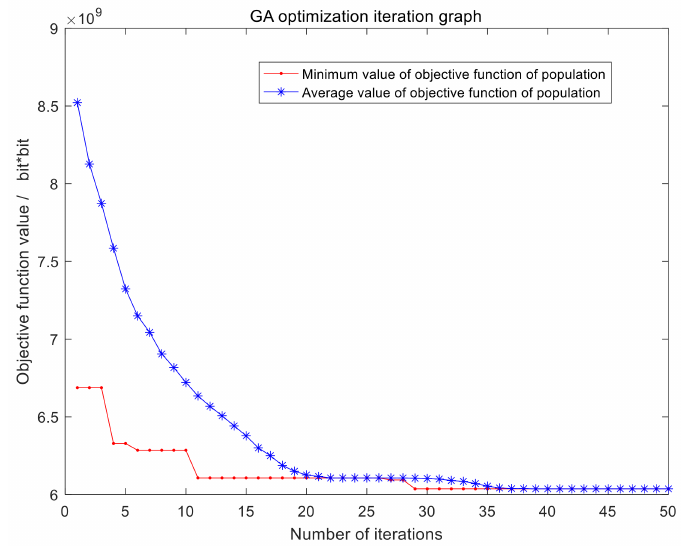
Figure 6. GA optimization iteration